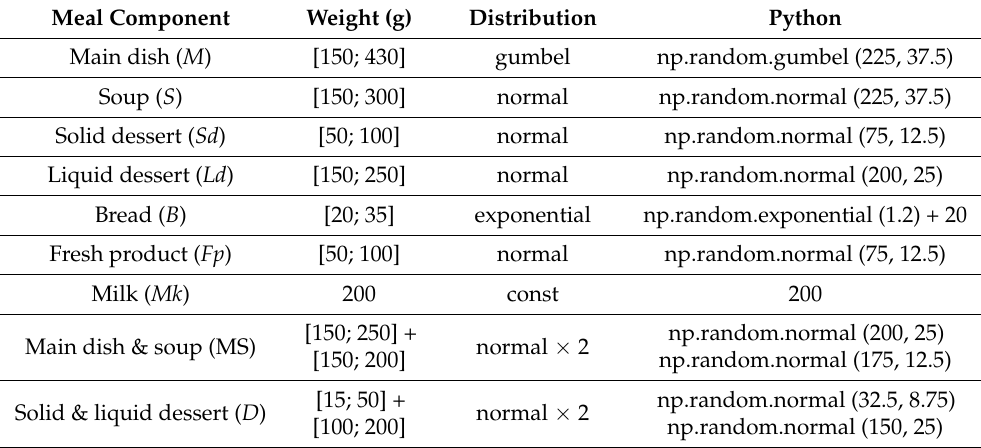
Table 1. Simulation parameters for meal portion generation.